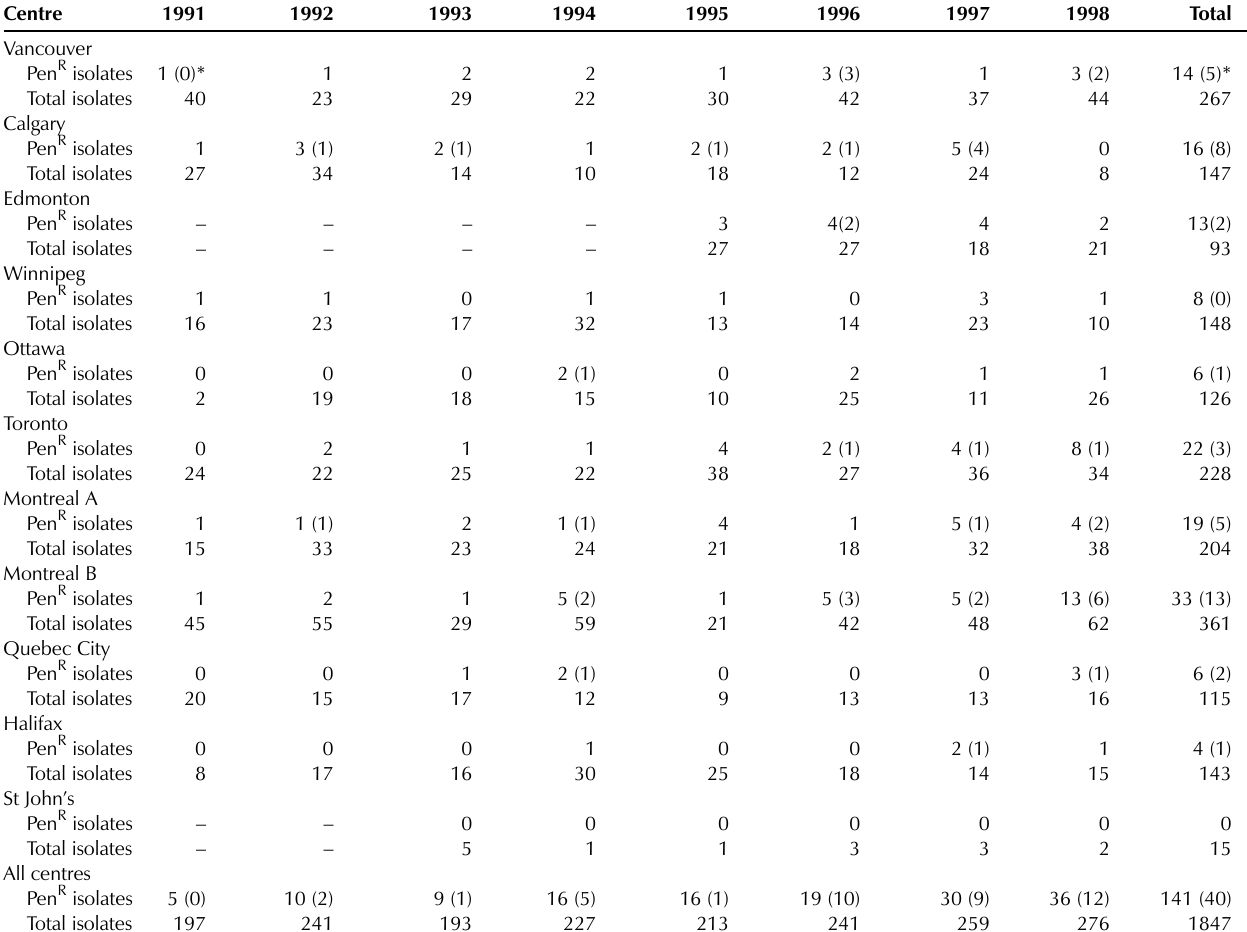
Distribution of isolates with reduced susceptibility to penicillin (Pen R ) among Canadian Paediatric Society/Laboratory Centre for Disease Control Immunization Monitoring Program, Active (IMPACT) centres, 1991 to 1998 Centre